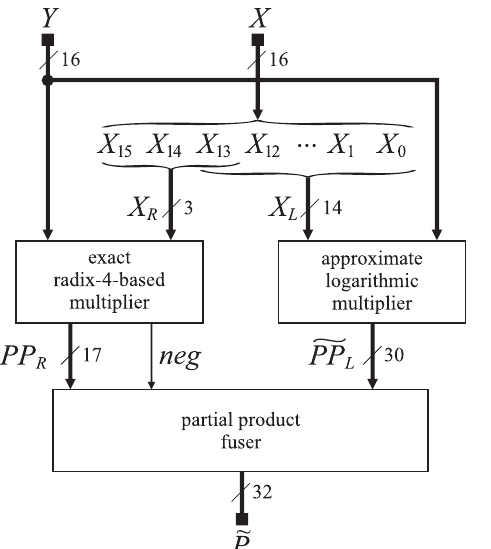
Figure 1. Architecture of the hybrid radix-4 and approximate logarithmic multiplier